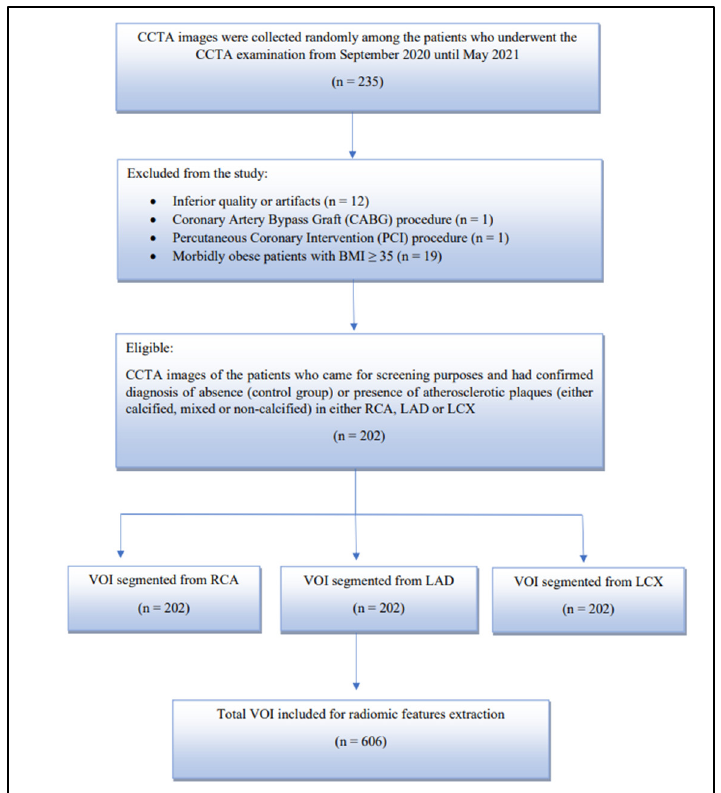
Figure 2. Overall flow of patient selection.